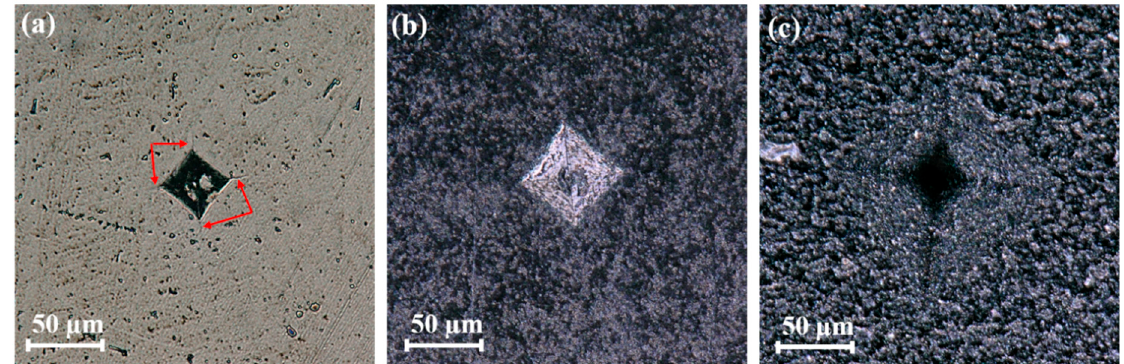
Figure 5. Optical microscopy images of indents after Vickers hardness measurements. ( a ) With 0 wt.% MLG, ( b ) with 5 wt.% MLG, and ( c ) with 30 wt.% MLG.